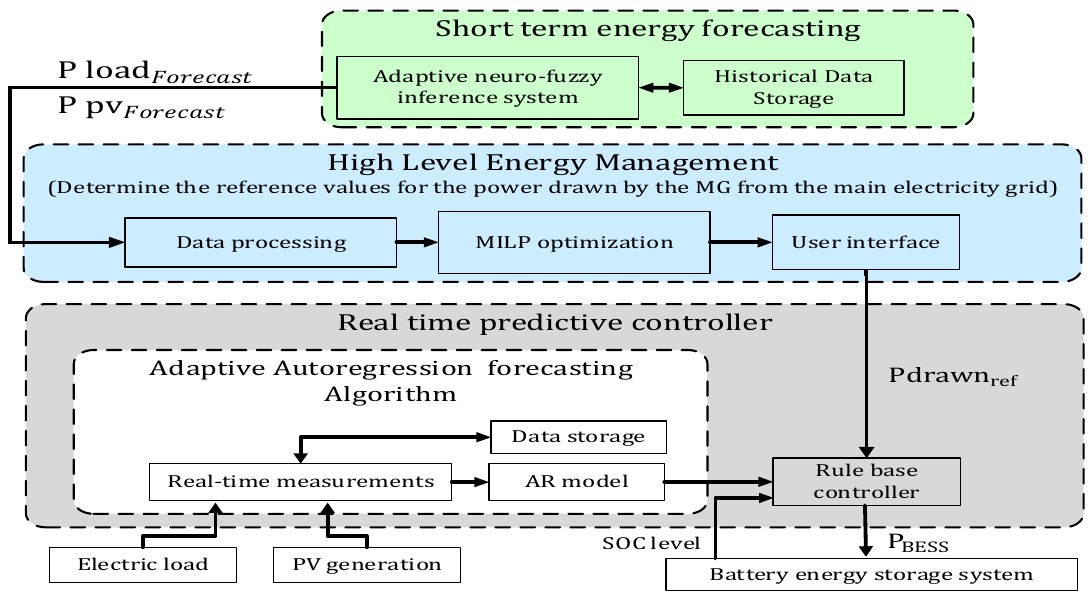
Figure 1. Hierarchical scheme of the microgrid energy management system.